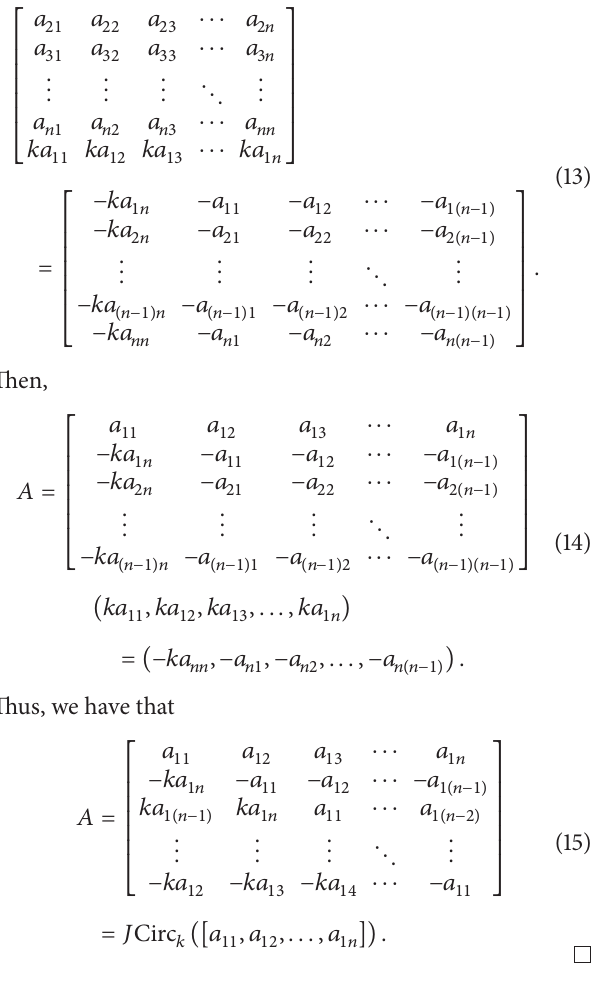
Algorithm 12. Compute a principal square root of a 𝑘 - circulant matrix 𝐴 ∈ C 𝑛×𝑛